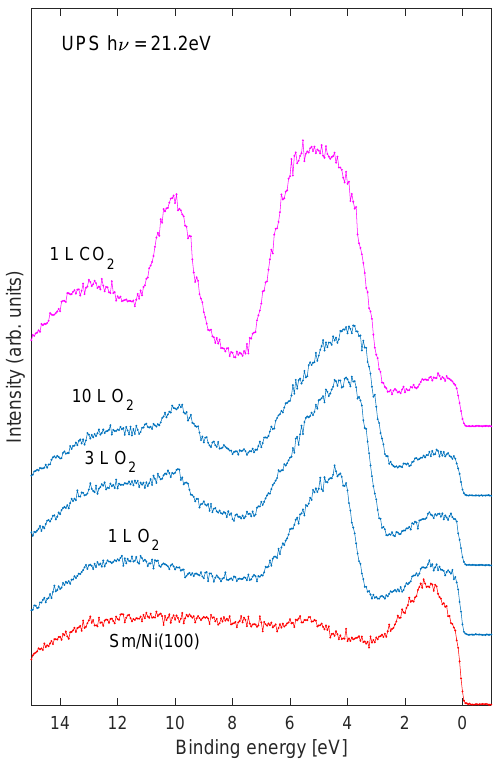
Figure 5. UPS of the valence band region of the Sm/Ni(100) sample. The effective Sm coverage was 0.8 ML.The bottom curve shows the clean Sm/Ni sample. The three curves in the middle show increasing exposure to oxygen, and the top spectrum shows exposure to CO 2 on the oxidized sample.